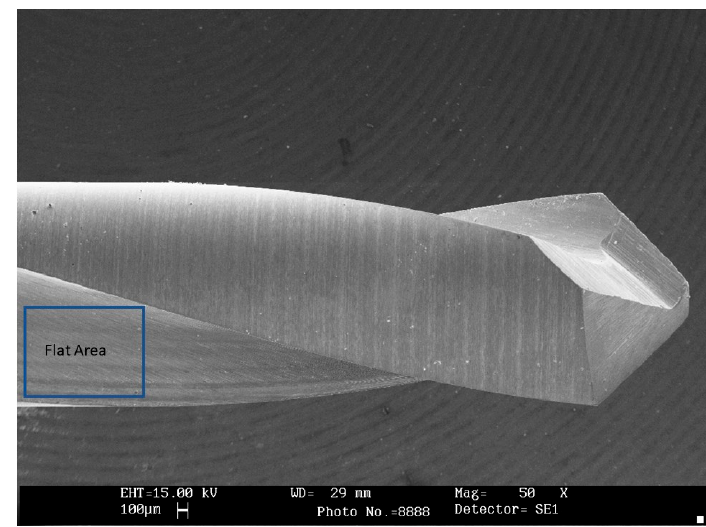
Figure 12. Macroscopic aspect of the steel drill (left) and zirconia drill (right) used in the present study.